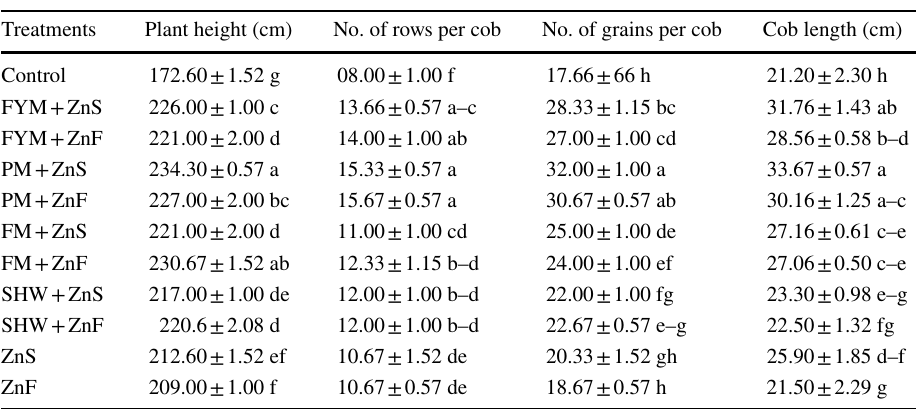
Different letters in the same column indicate significant differences by LSD at P ≤ 0.05 and ± indicate standard error ( n =